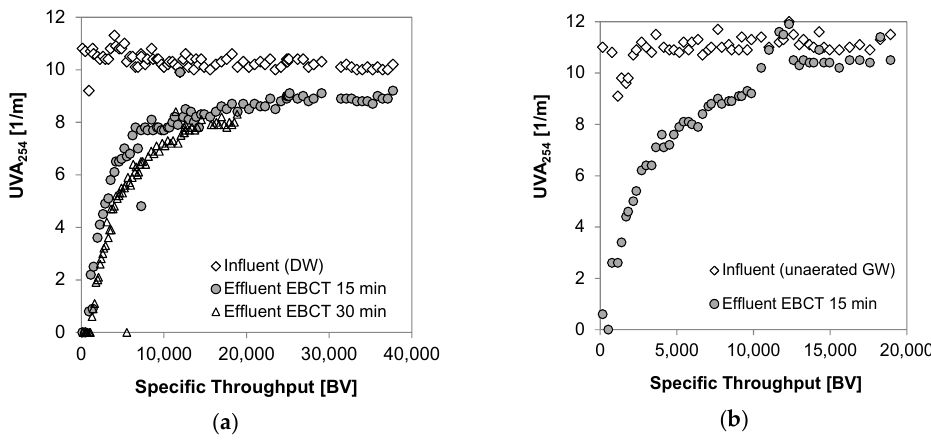
Figure 5. UVA 254 breakthrough curves of ( a ) two fixed-bed adsorbers in series fed with drinking water; and ( b ) a single fixed-bed adsorber fed with un-aerated groundwater.